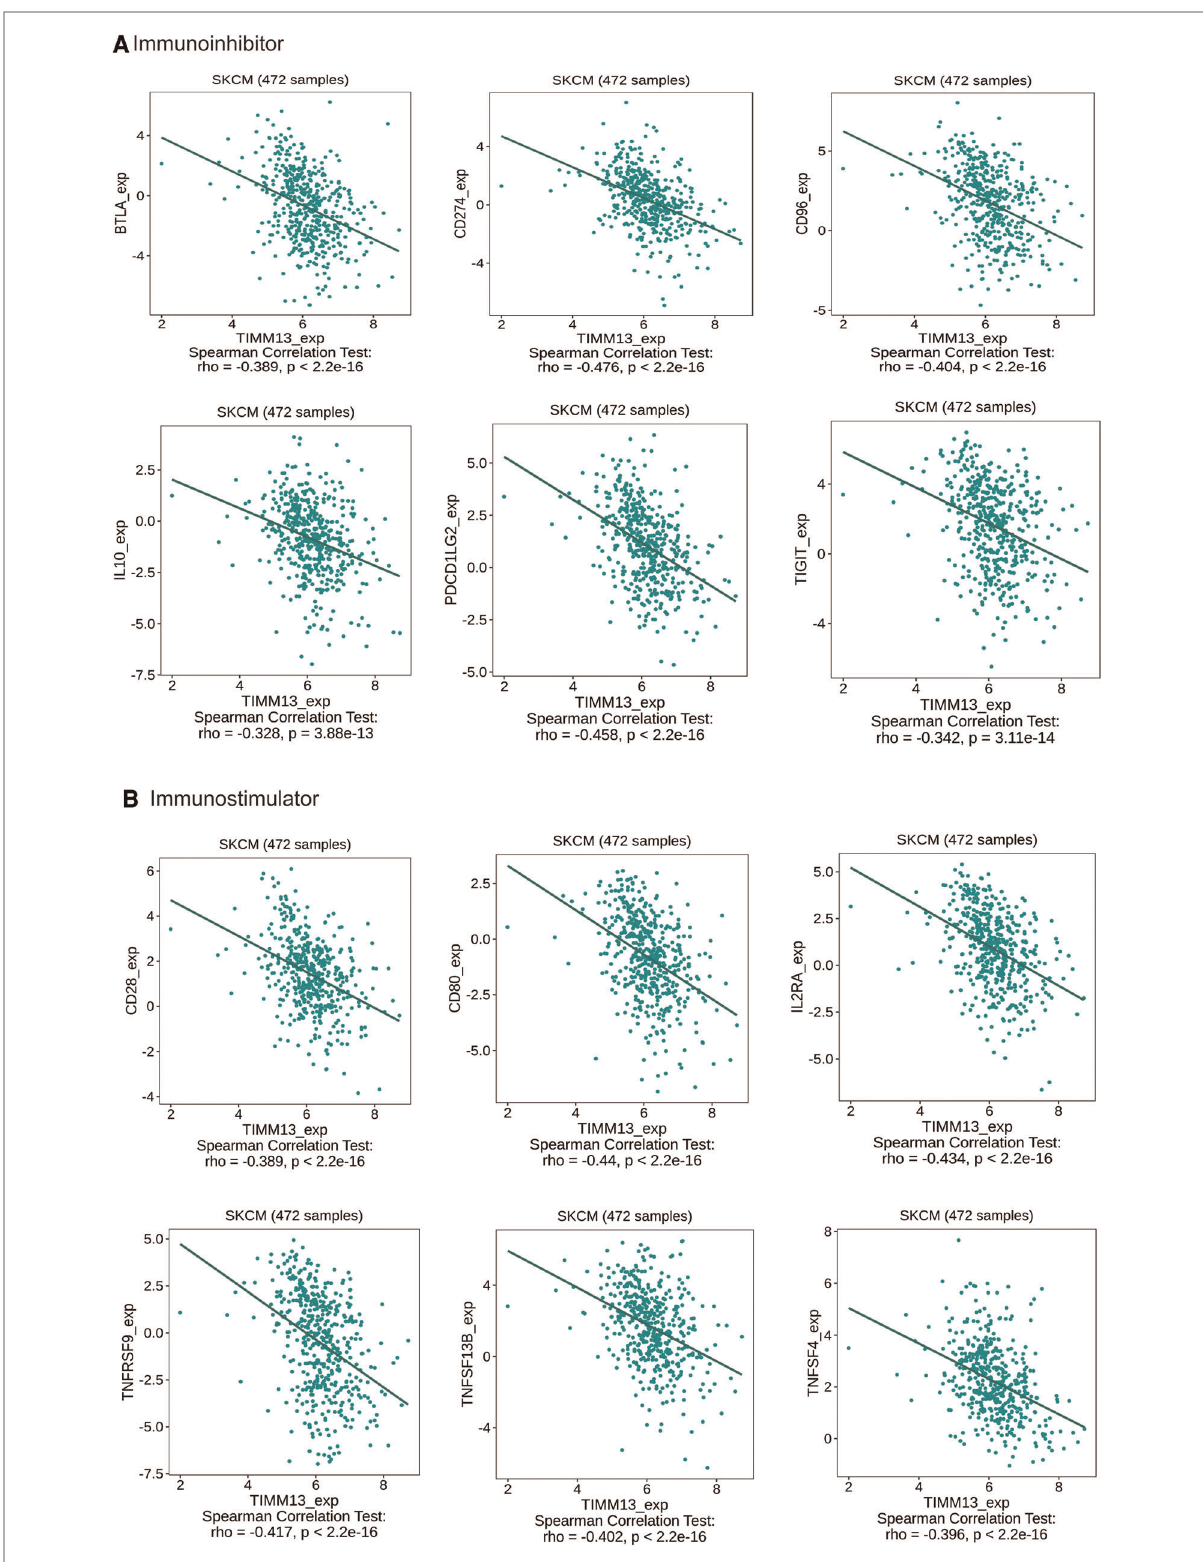
FIGURE 5 The expression of TIMM13 is associated with immunomodulators in SKCM. ( A ) Correlation between TIMM13 expression and immunoinhibitors in SKCM available at TISIDB database. ( B ) Correlation between TIMM13 expression and immunostimulators in SKCM available at TISIDB database. Color images are available